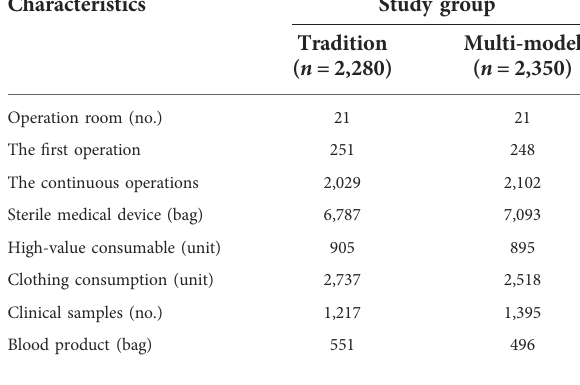
TABLE 2 Clinical characteristics of operation department under traditional process group and multimodal practice